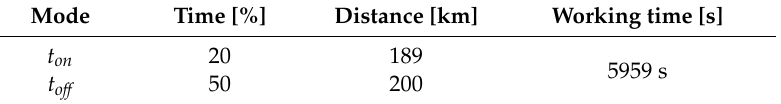
Table 8. On-o ff control mode in the last cycle. Table 8. On-off control mode in the last cycle.